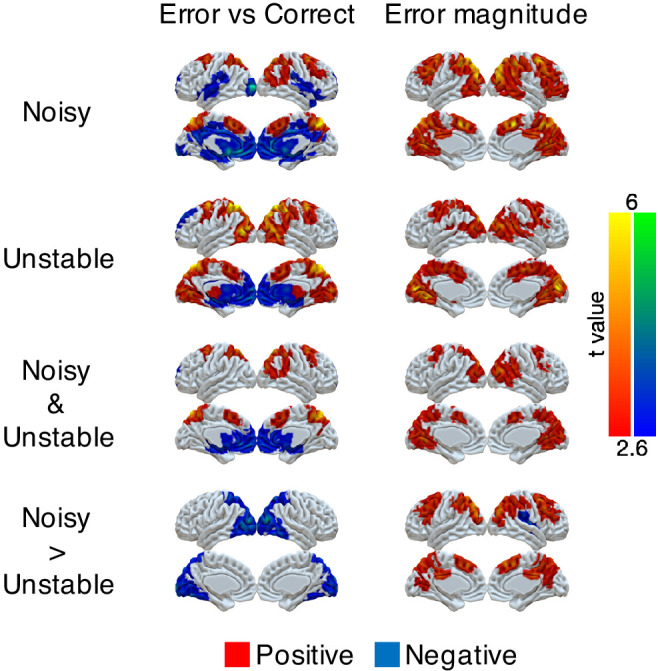
Univariate representations of error and error magnitude.A GLM was implemented on the preprocessed fMRI data (smoothed with 6 mm FWHM Gaussian kernel). The trial-by-trial regressors of interest that were included in the GLM were: onset of correct trials, earnable value on correct trials, onset of error trials, error magnitude on error trials, switch or stay on error trials and earnable value on error trials. We focused on the effects of error (which is the difference between the onset of error trials and the onset of correct trials) and error magnitude. Group t-values are shown. For statistical testing, we implemented one-sample cluster-mass permutation tests with 5000 iterations. The cluster-forming threshold was uncorrected voxel p<0.01 (t = 2.6).